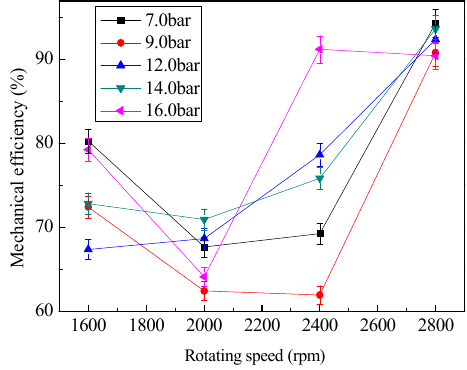
Figure 9. Mechanical efficiency versus rotating speed.